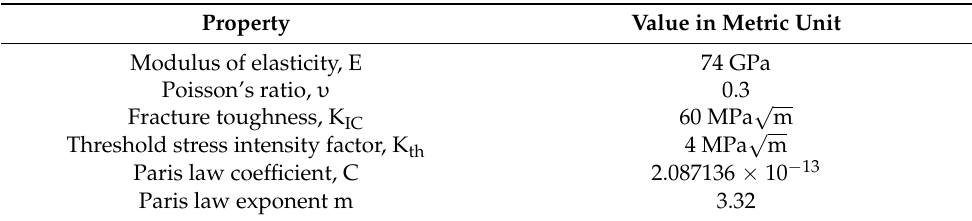
Figure 4. ( a ) Problem statement for two internal non-colinear cracks (all dimensions in mm) and ( b ) adaptive mesh for the specimen. Table 1. Material properties of